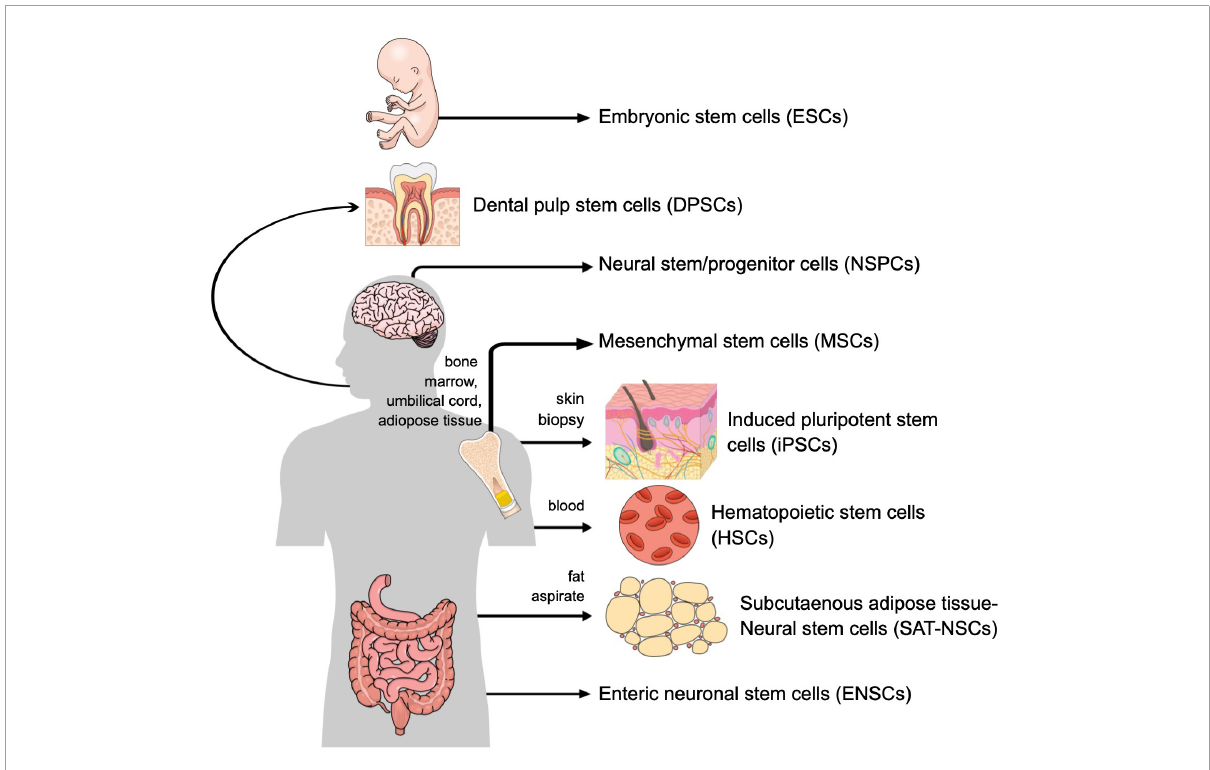
FIGURE1 Cell sources for regenerative central nervous system (CNS) therapy.